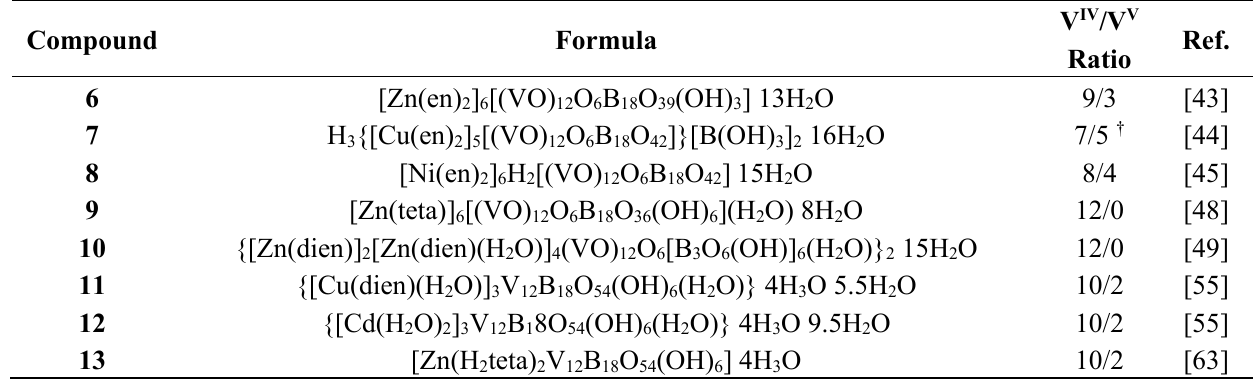
Table 2. List of the lattices with transition metal ions and coordination compounds as counterbalancing ions. The mixed valence V IV /V V ratio is indicated for each lattice. Compound Formula